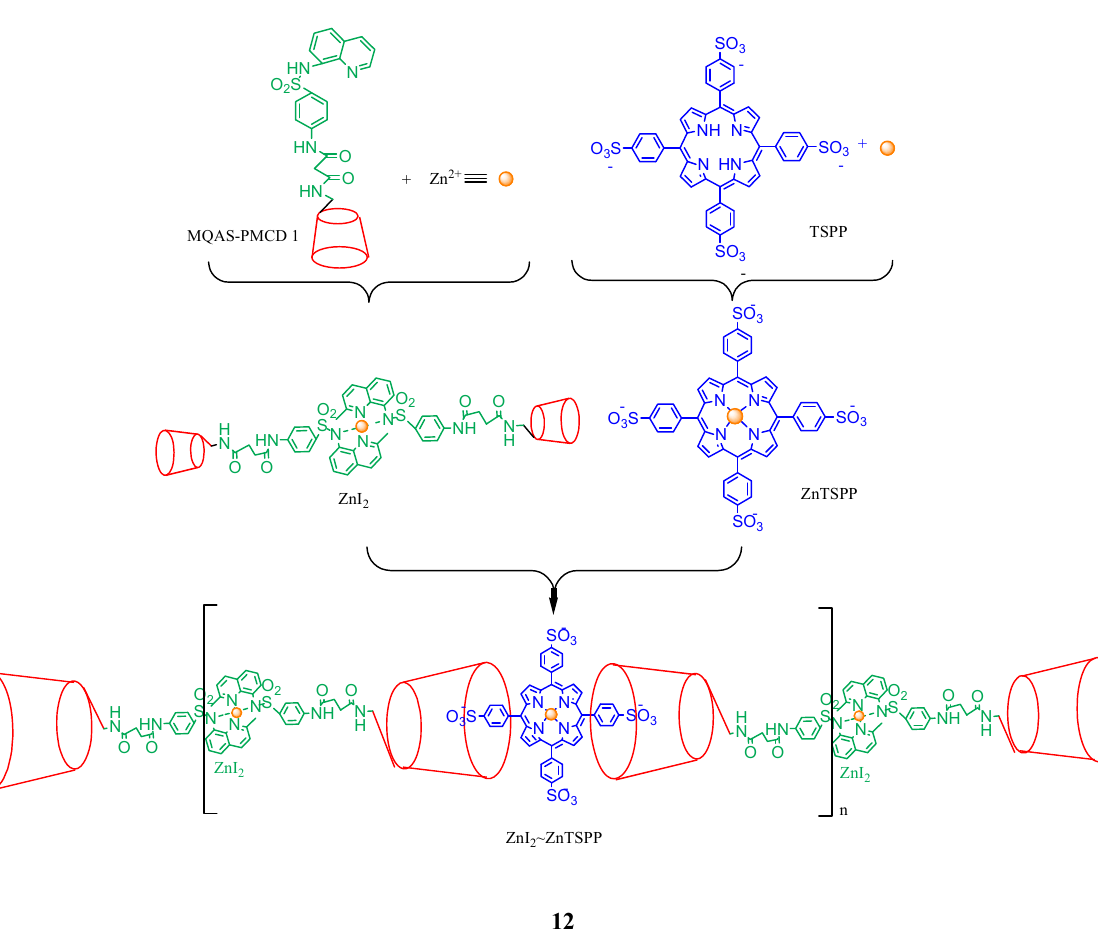
Figure 13. Schematic representation of the synthesis of the Zn 2+ /cyclodextrin/porphyrin triad ( 12